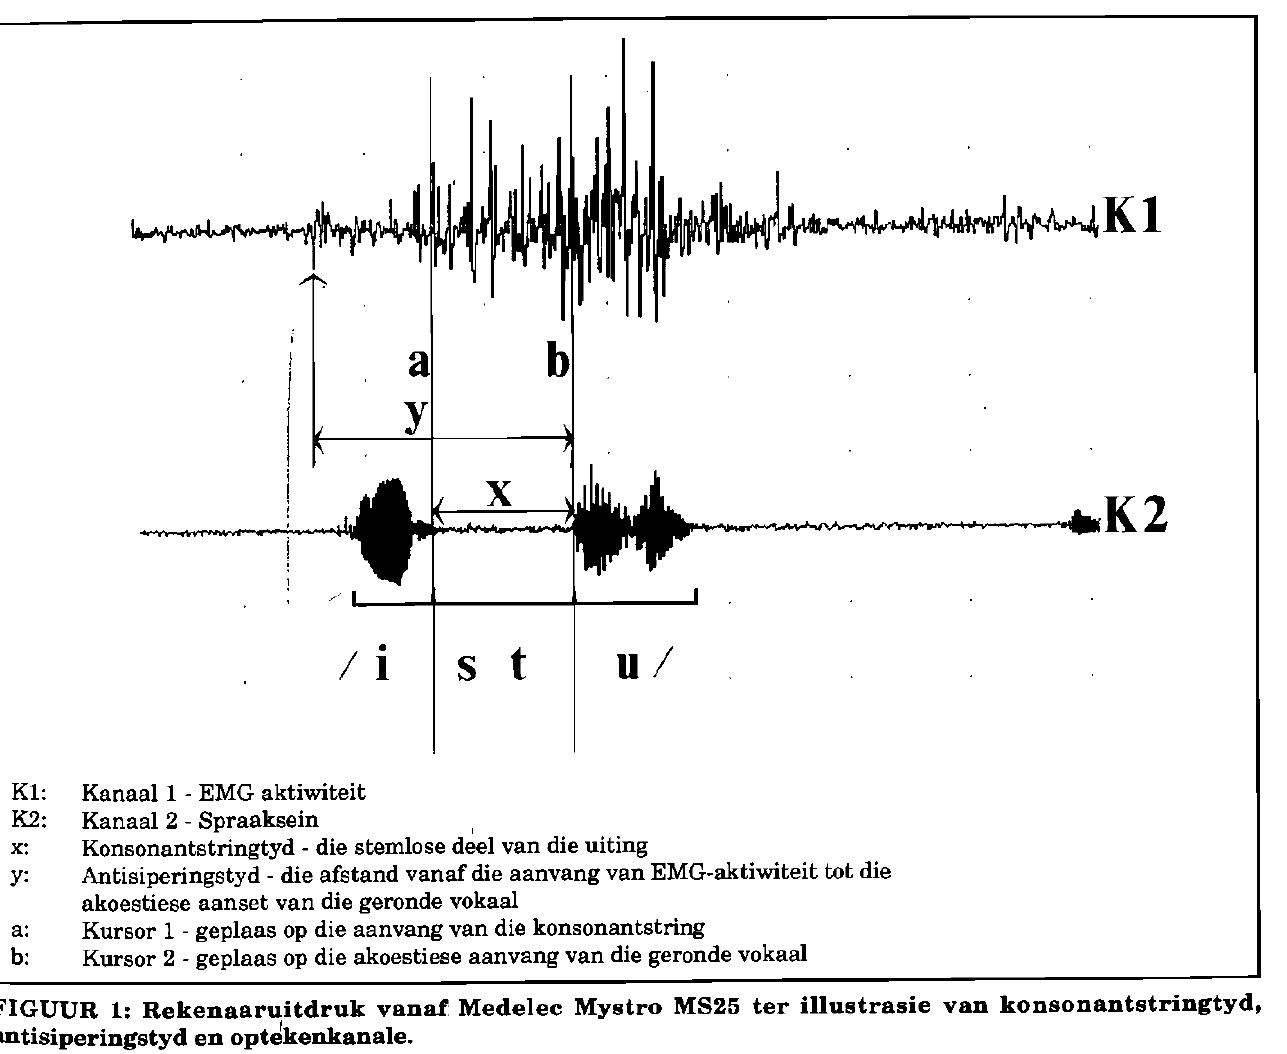
FIGUUR 1: Rekenaaruitdruk vanaf Medelec Mystro MS25 ter illustrasie van konsonantstringtyd, antisiperingstyd en